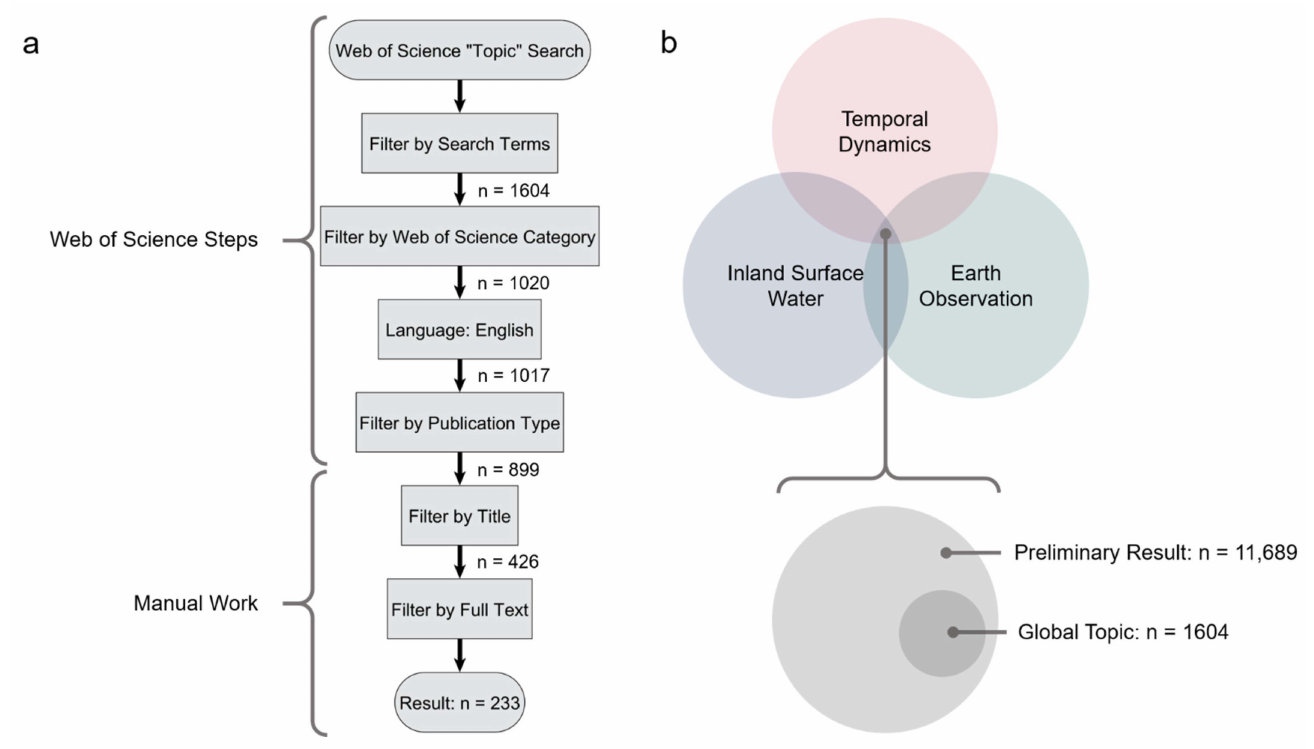
Figure 2. ( a ) Flowchart of filtering process to arrive at n = 233 publications. ( b ) Outline of the initial Web of Science “topic” search using search